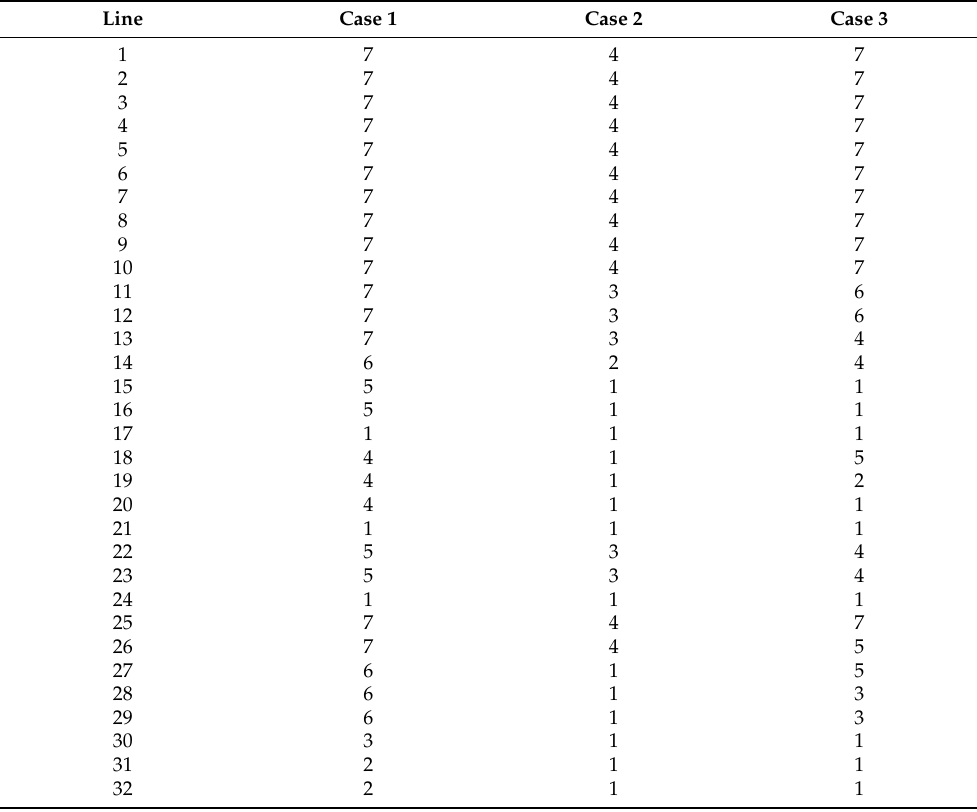
Table 16. Conductors selected for the IEEE 33-bus grid at each operative scenario. Line Case 1 Case 2